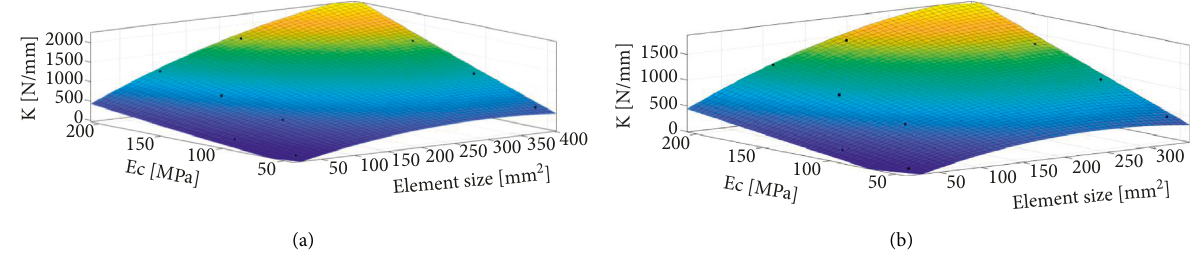
� 175) and (b) outstand plate ( b / t � 50). c and A : (a) internal plate ( b / t